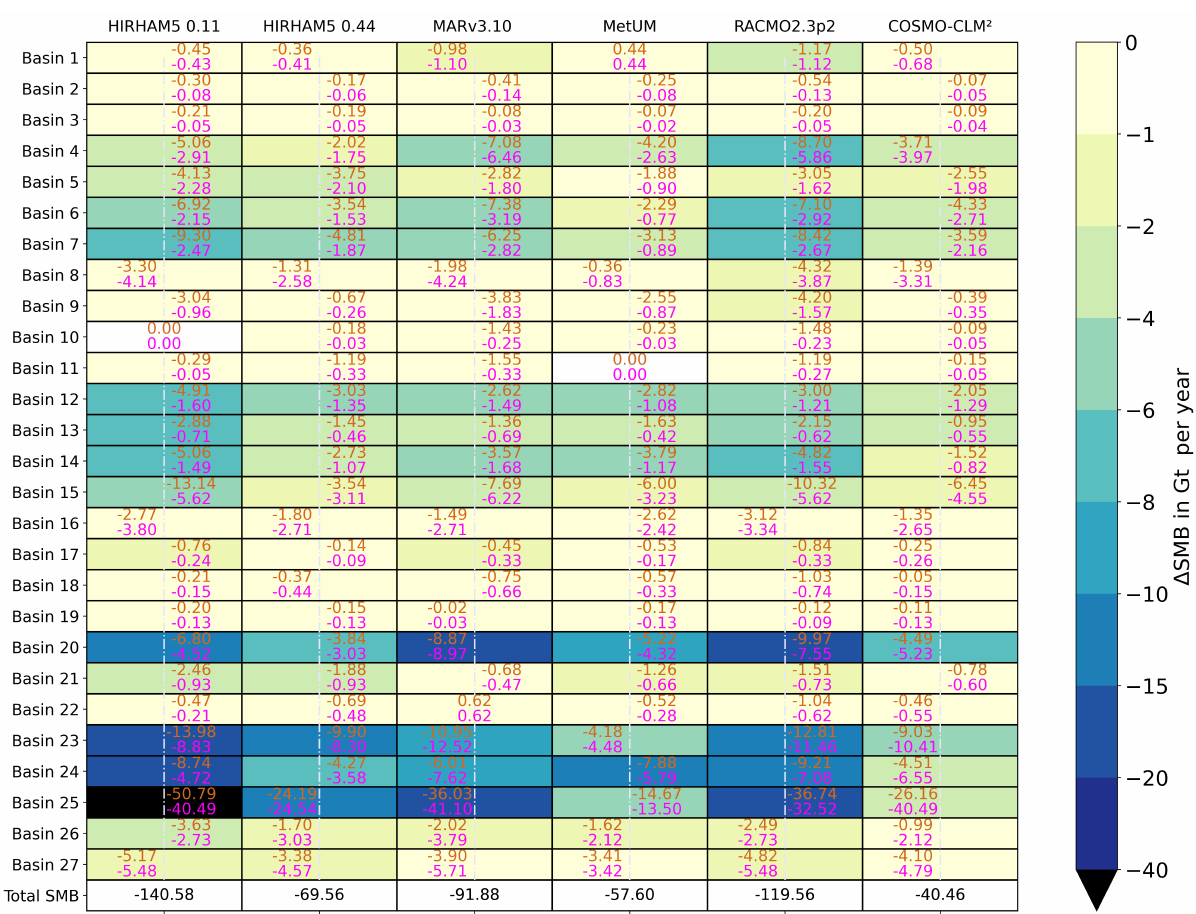
Table 2. Rows 1 to 27 are basins, and the columns are the RCMs. There are two numbers in each grid cell: the bottom number in magenta is the difference in area between the common mask and native masks ( (cid:49) area % ) in each basin. The upper number in orange shows the difference in SMB between the common mask and native masks ( (cid:49) SMB % ) in each basin. The grid cell colour shows the difference in SMB in Gtyr − 1 ( (cid:49) SMB ). All calculations are derived by subtracting the native mask from the common mask ( (cid:49) = common − native). The differences Gtyr -1 are shifted left if (cid:49) area % is greater than (cid:49) SMB % and right if (cid:49) SMB % is greater than (cid:49) area % . The bottom row is the summed (cid:49) SMB values over 27 basins, for each